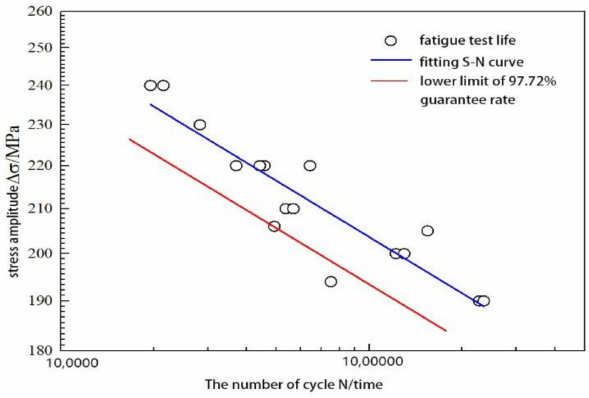
Figure 9. S-N curve of M24 high-strength bolts obtained from the